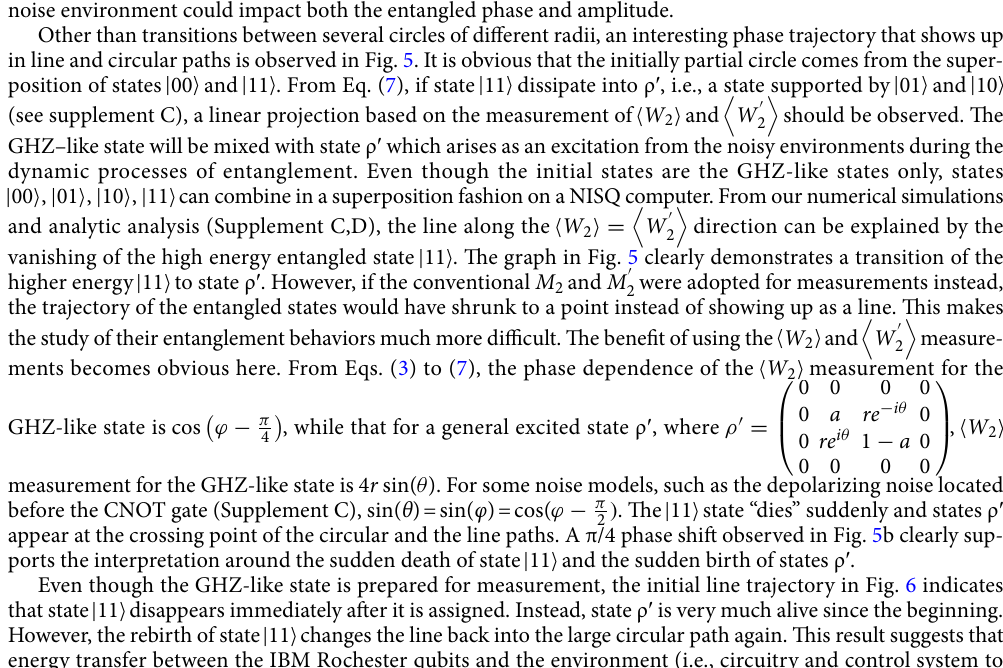
Figure 5. A transition pattern between a circle and a line for maximal value of the GHZ-like state is 2 √ 2